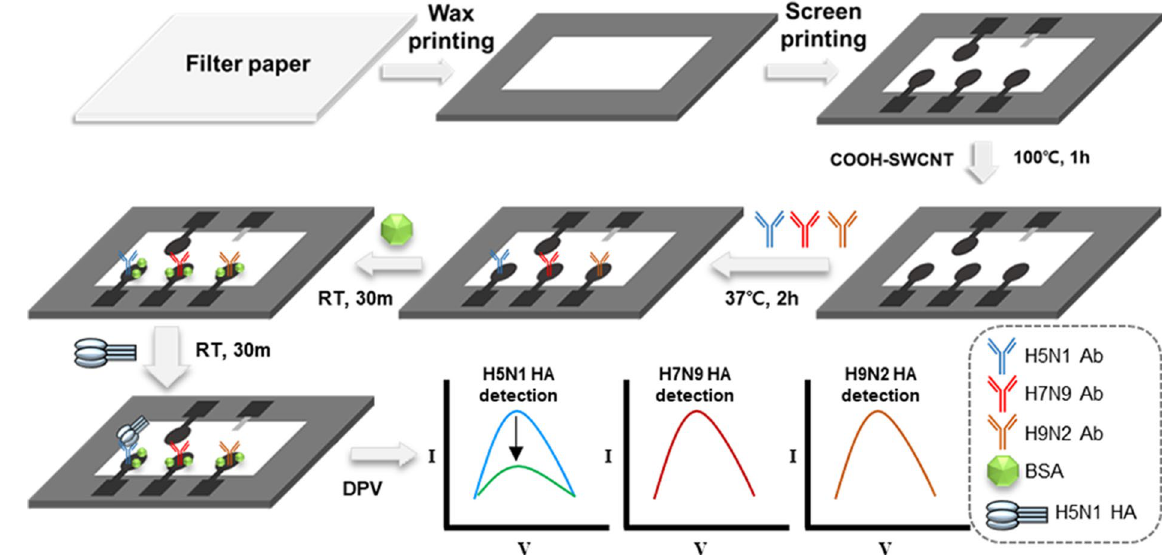
Figure 1. Schematic of the proposed paper-based electrochemical immunosensor for detection of three different avian influenza virus antigens. Here, H5N1 HA alone is present on the sensor for the purpose of illustration. RTs stand for room temperature, ~ 25 ℃